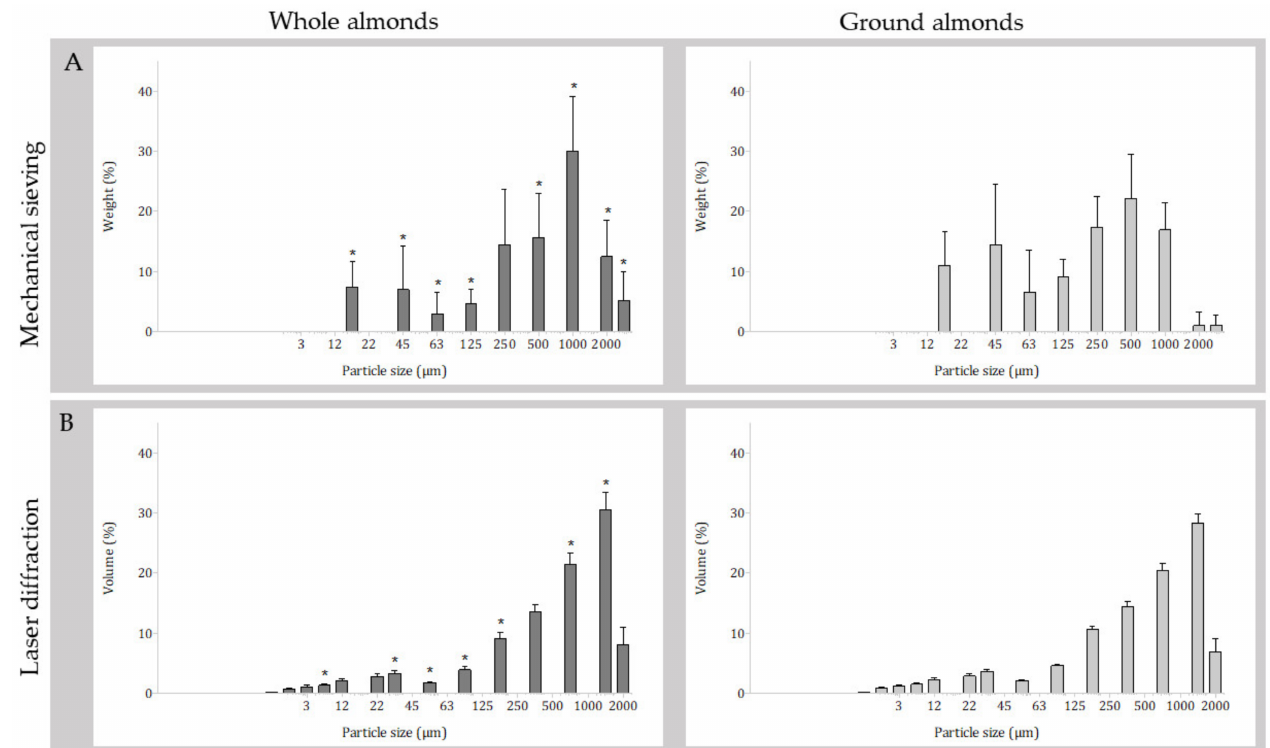
Figure 2. Particle size distributions of masticated whole and ground almonds ( A ) measured by mechanical sieving; bars are mean weight recovered; n = 31 participants provided paired data; and ( B ) measured by laser diffraction; bars are mean volume; n = 25 participants provided paired data. Error bars are standard deviation; (*) indicates significant difference between almond forms for that method ( p <